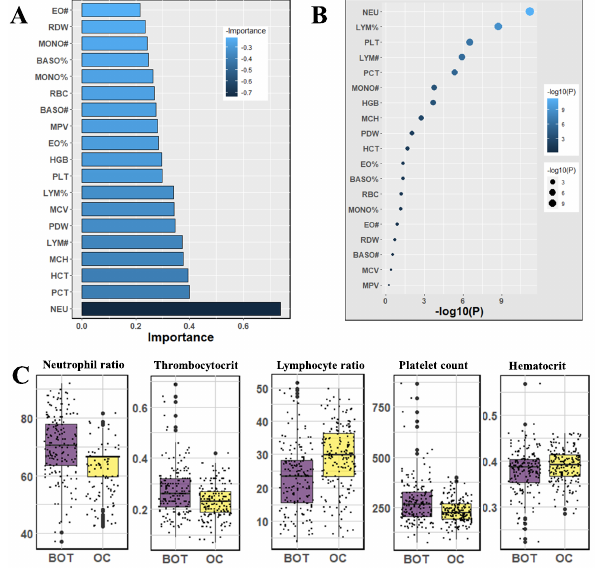
Figure 2. The analysis results for the dataset blood samples; ( A ) The feature importance of blood samples calculated by ML algorithms according to coefficient values after model training; ( B ) The association between benign ovarian tumor and ovarian cancer patients applying independent sample t -test, the lighter and larger bubble represent higher association; ( C ) The box plot of the five top most associated blood samples.